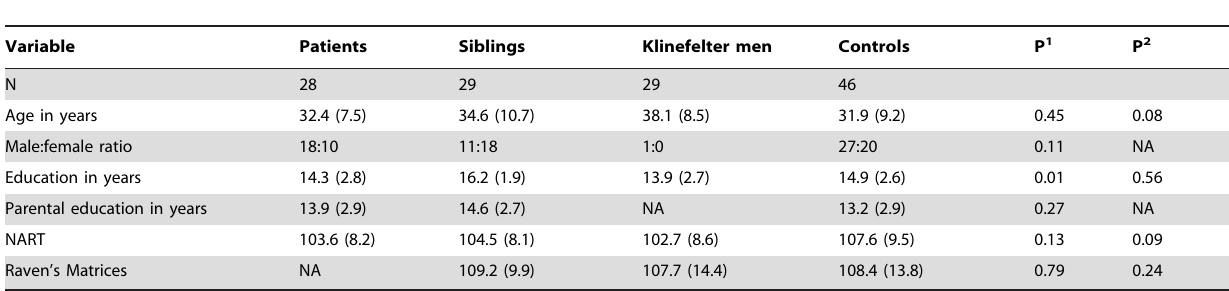
Table 1. Demographic data (mean (SD)) of participants included in the Social Distance Judgment Task analysis.